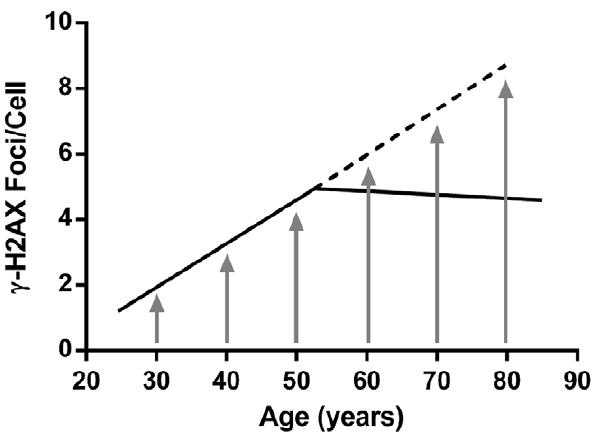
Figure 5. Theoretical vs. actual pattern for average number of c -H2AX foci/cell by age. Expected increase of the average number of c -H2AX foci/cell for each age group would theoretically mimic the prevalence of disease for that age group (shown by arrows) given that healthier patients have lower counts and morbid patients have higher counts. Solid line models actual patterns for Sedelnikova et al. [11] and the present study. The dashed line represents theoretical averages if a cross-section for an entire age group for a given population could be measured. Many patients, however, with morbidities such as metastatic cancer, dementia, heart disease and diabetes may not volunteer, be available or be eligible for sampling studies thus possibly skewing results toward healthier